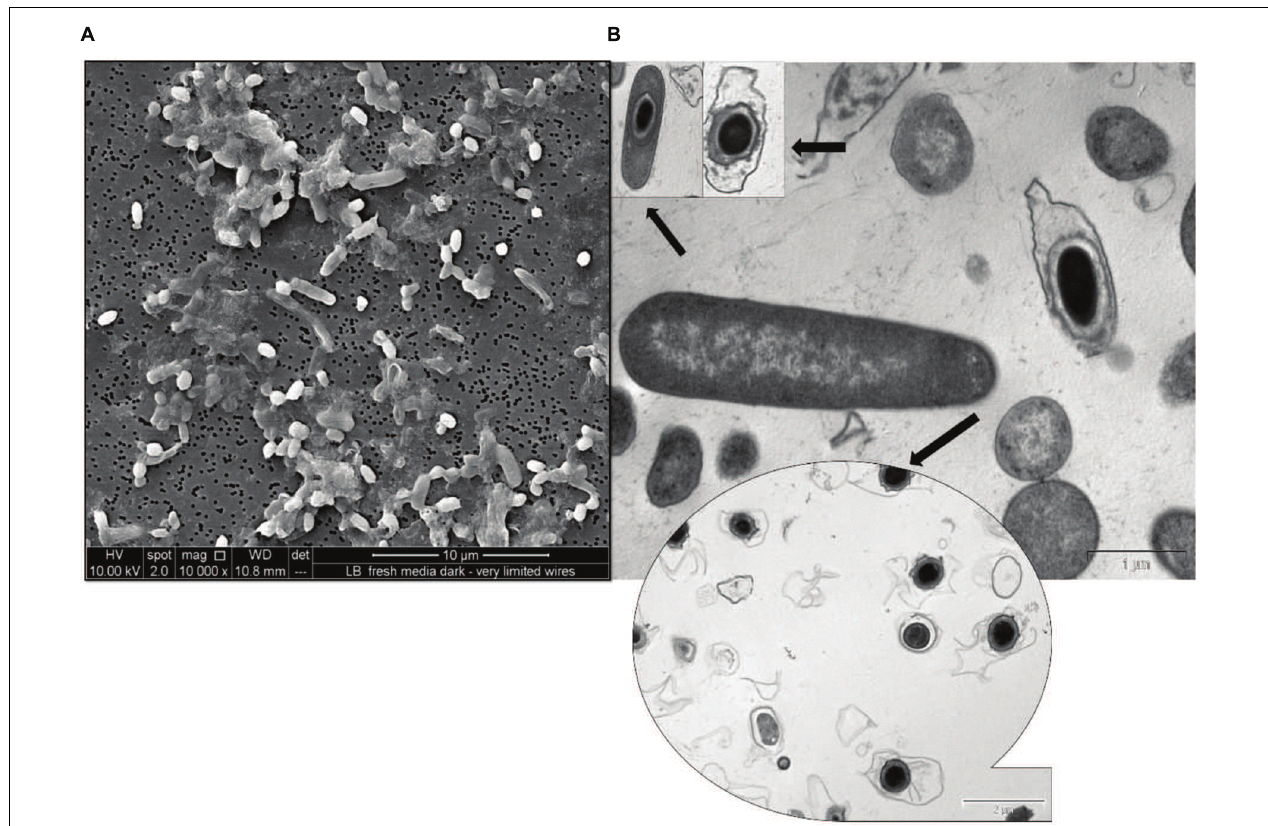
FIGURE 1 | Micrographs of spore formation in chemosynthetically grown cells of R. palustris strain RP2. (A) SEM micrograph. (B) TEM micrograph.